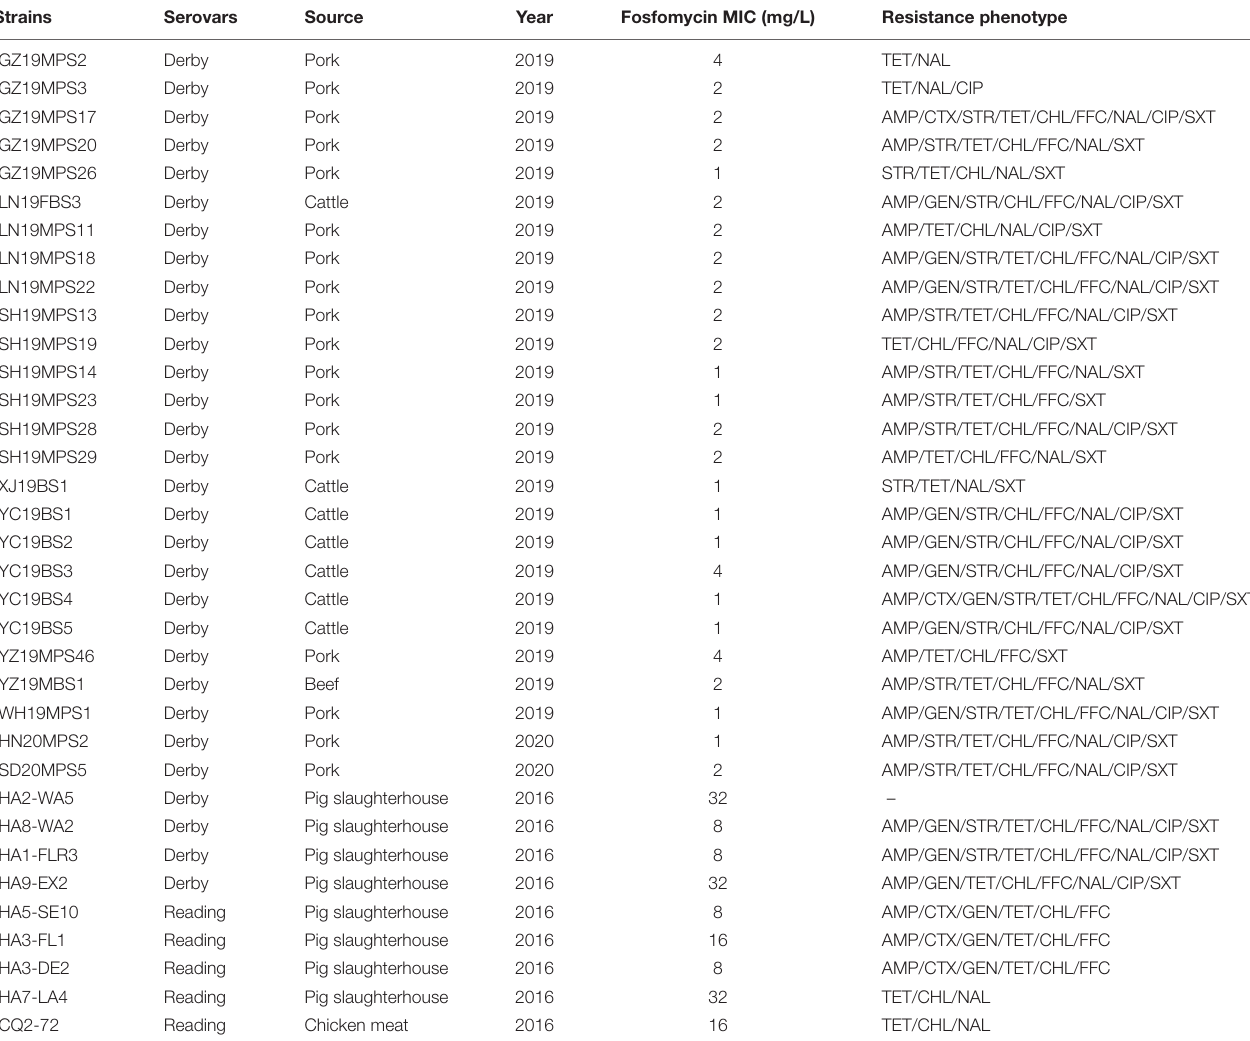
TABLE 1 | Antimicrobial susceptibility results of fosA7 -positive Salmonella isolates in this study. Strains Serovars Source Year Fosfomycin MIC